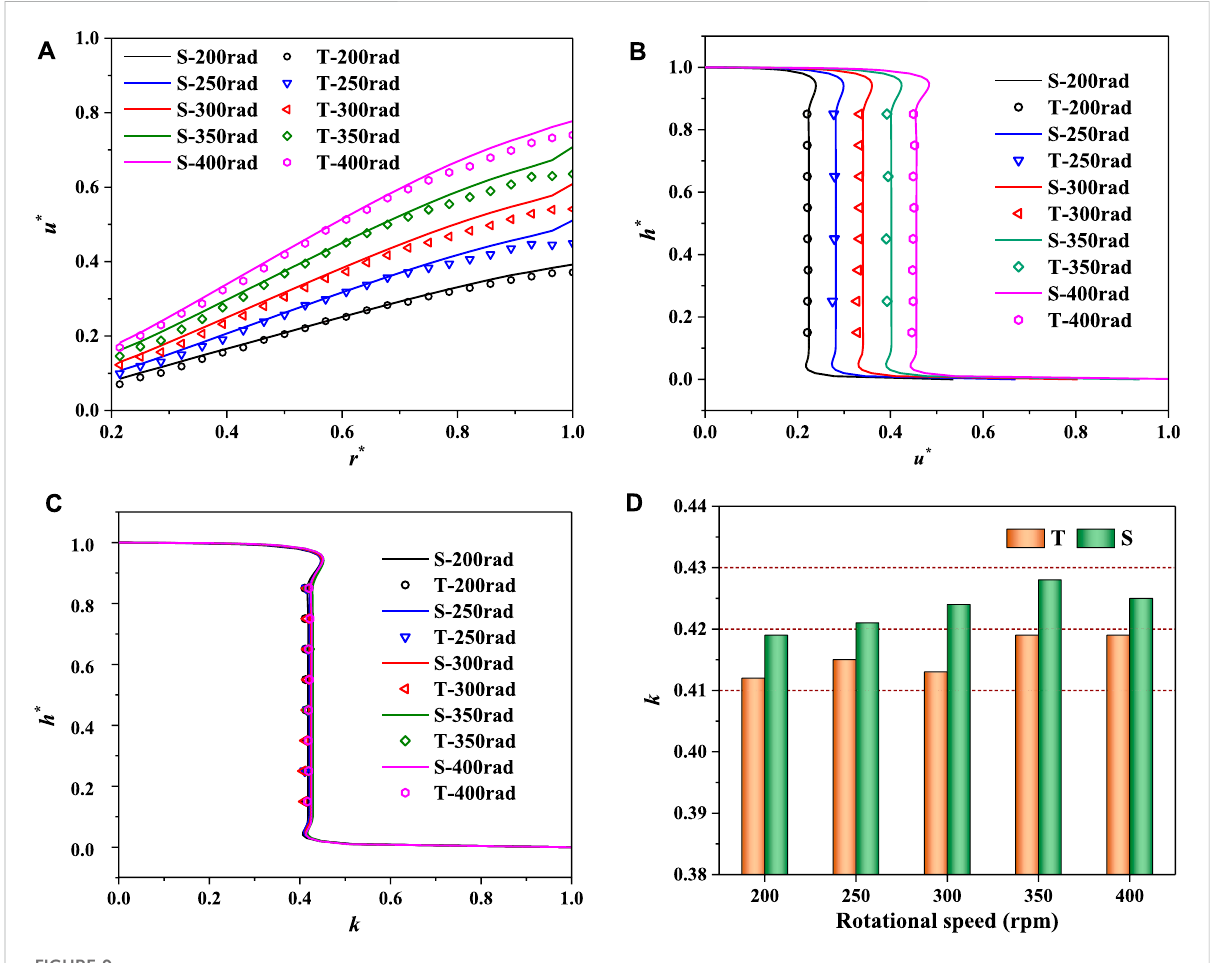
FIGURE 9 Circumferential velocity distributions under different disk rotating speeds. (A) Radial distribution (0 . 45 h 0 ). (B) Height distribution ( r p =0.536 m). (C) Rotating coef fi cient k distribution. (D) Rotating coef fi cient k in the core